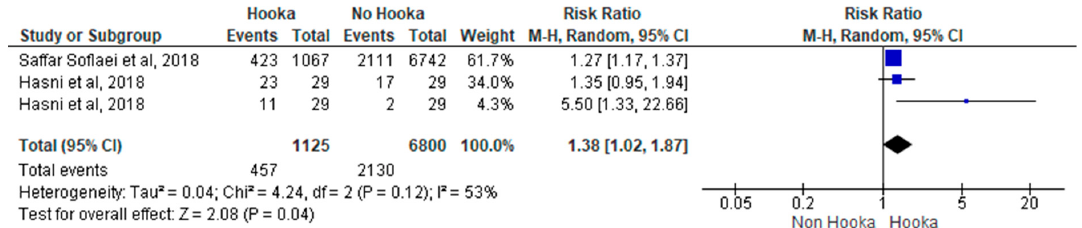
Figure 2. The forest plot for the risk of obesity with hookah-smoking.